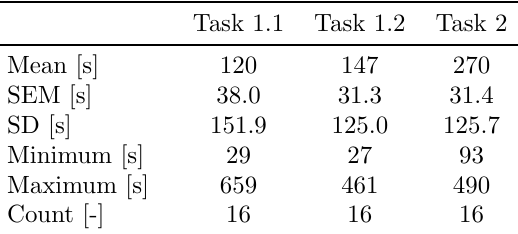
Table 3: Execution time results of TGUI Task 1.1 Task 1.2